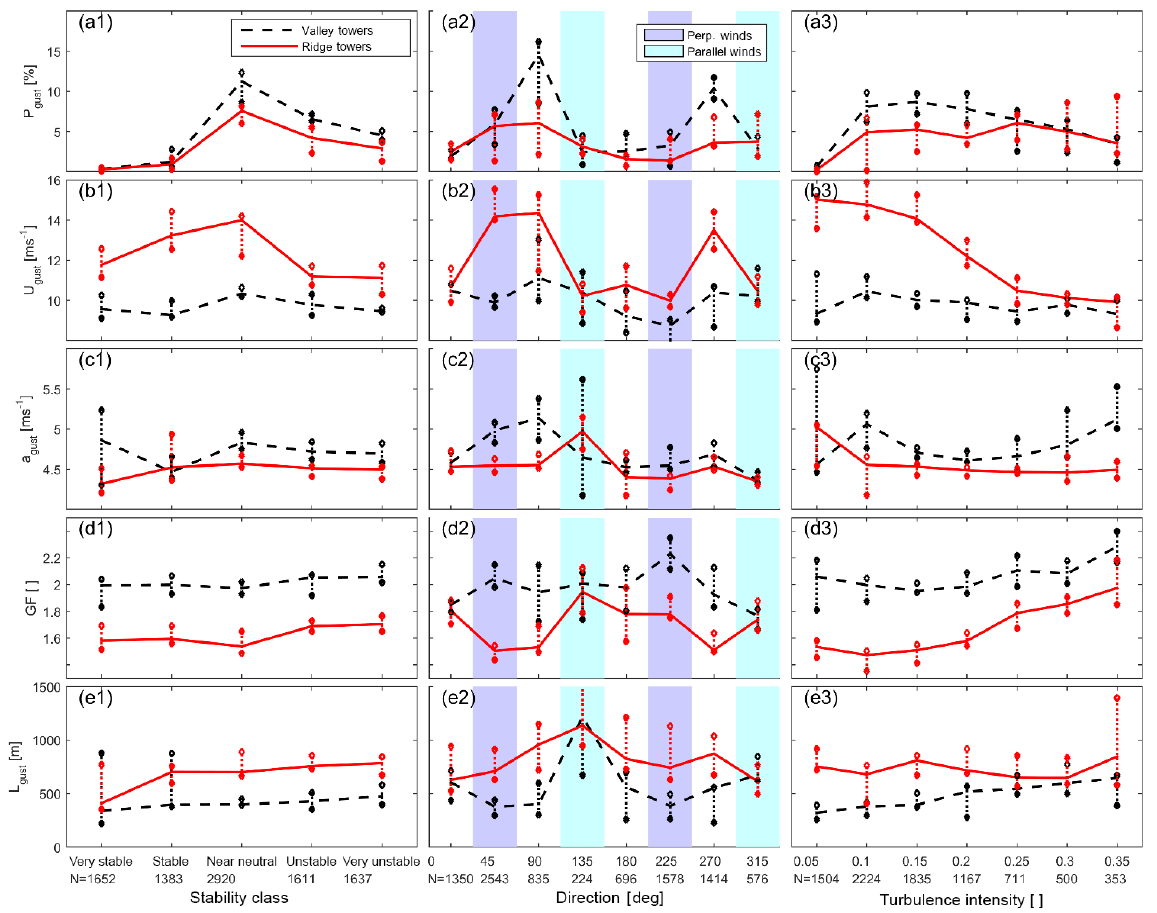
Figure 6. Median gust parameters during gusty conditions ( U mean > 3ms − 1 , a gust > 4ms − 1 ) at 60ma.g.l. from ridge (solid red) and valley (dashed black) towers. The data sampled are conditionally sampled by stability classes based on Monin–Obukhov length (column 1), wind direction (column 2), and turbulence intensity (column 3) as measured at Tower 29 (60ma.g.l.). Vertical whiskers at each data point denote the range of median parameter values for all towers in each class. N values in the second row of x axis labels are the number of 10min periods in each sample. One gust parameter is shown per row: (a) probability of a gust (i.e., percentage of 10min periods that meet the gust criteria), (b) gust magnitude ( U gust ), (c) gust amplitude ( a gust ), (d) gust factor GF, and (e) gust length scale ( L gust